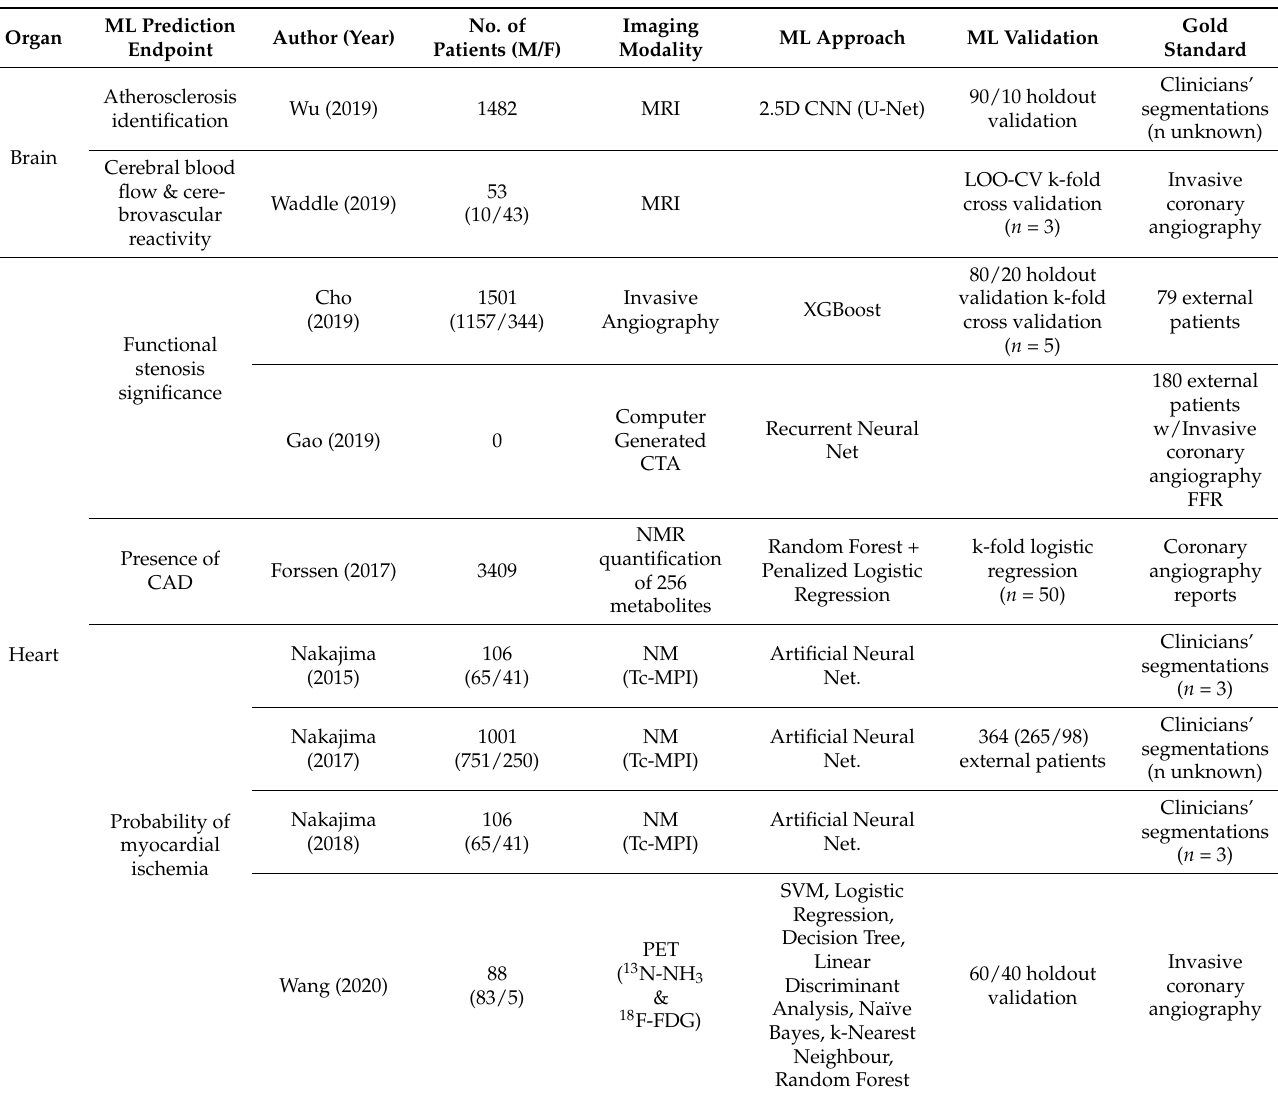
Table 6. Characteristics of modalities other than CT and